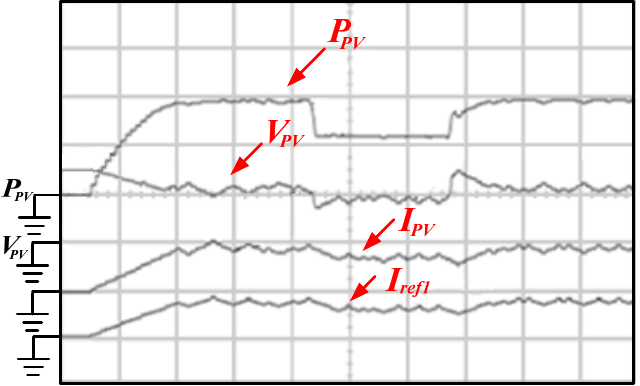
: 100 W/div, V : 200 V/div, I : 2 A/div, I : 2 V/div, time : 10 PV PV PV ref_1